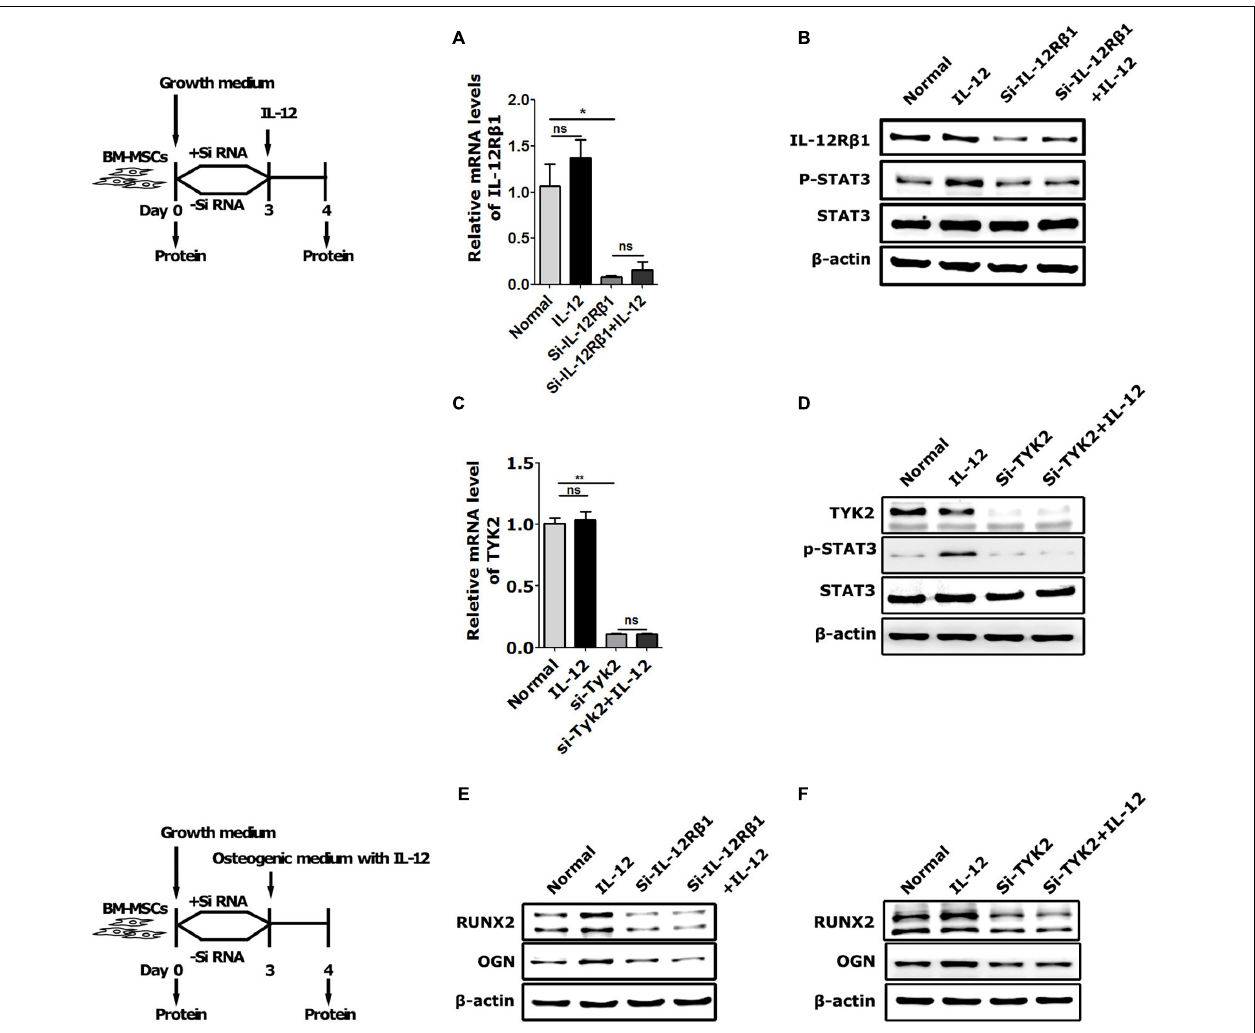
FIGURE 4 | The role of IL-12R β 1/TYK2 signal in IL-12-induced osteogenesis of BM-MSCs. (A–D) qRT-PCR analysis and western blot analysis of expressions of IL-12R β 1, STAT3, and p- STAT3 in IL-12R β 1 and TYK2 siRNA transfected cells co-cultured in complete media with or without 0.2 ng/ml IL-12 for 24 h. All the data were presented as the mean ± SEM, n = 3. The results were considered no significant at ns, and significant at * P < 0.05 and ** P < 0.01. (E,F) Western blot analysis of expressions of Runx2, Ogn in IL-12R β 1, and Tyk2 siRNA transfected co-cultured in osteogenesis inducing medium with or without 0.2 ng/ml IL-12 for 24 h. The cells without transfection were cultured without IL-12 used as